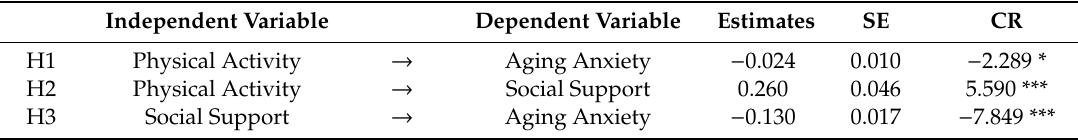
Table 8. Path coe ffi cients of mediation model.